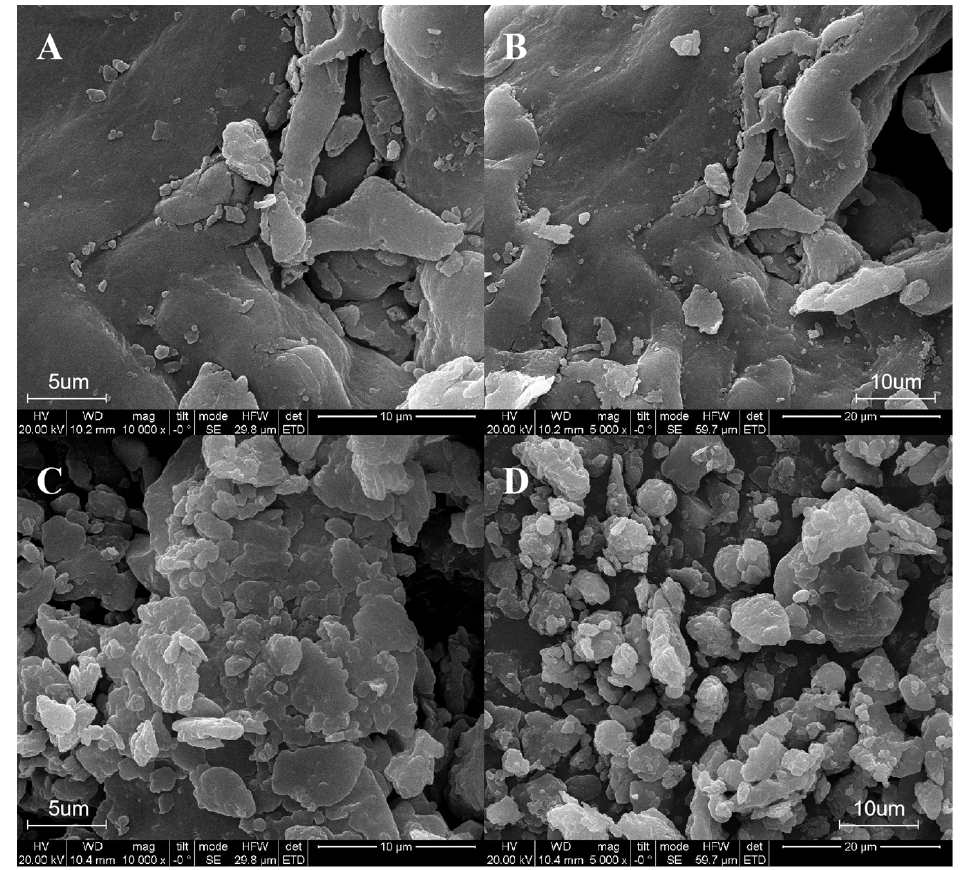
Figure 1. SEM analyses of FSDF and FIDF at 10,000× and 5000× magnification. ( A ) FSDF × 10,000; ( B ) FSDF × 5000; ( C ) FIDF × 10,000; ( D ) FIDF × 5000.